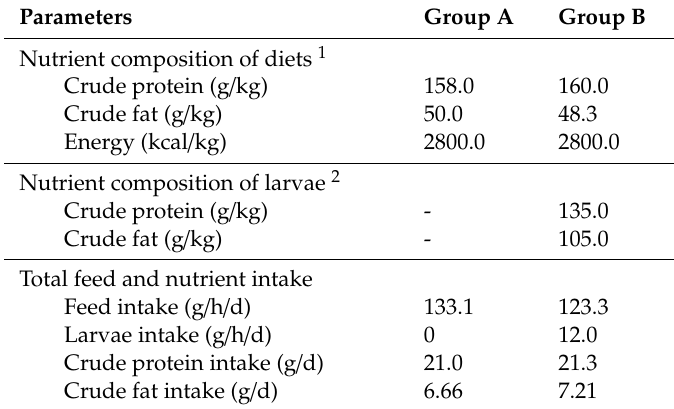
Table 6. Total crude protein and fat intake by laying hens fed with a commercial diet (Group A) or a soy-free diet + live larvae (Group B) from 67 to 78 weeks of age (as in basis).